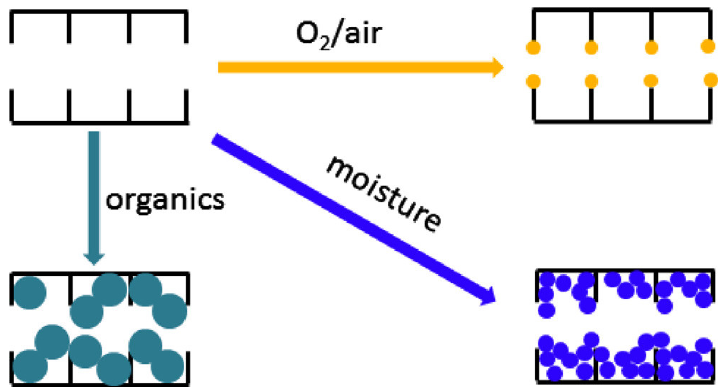
Figure 17. Mechanism of chemical aging in CMS membranes. Adapted from [91] with permission. Copyright (2014) Elsevier.